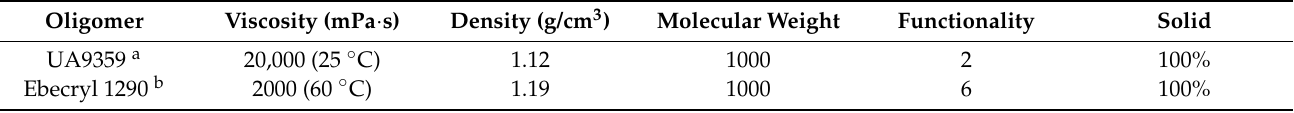
Table 1. Physical characteristics of oligomers used in this